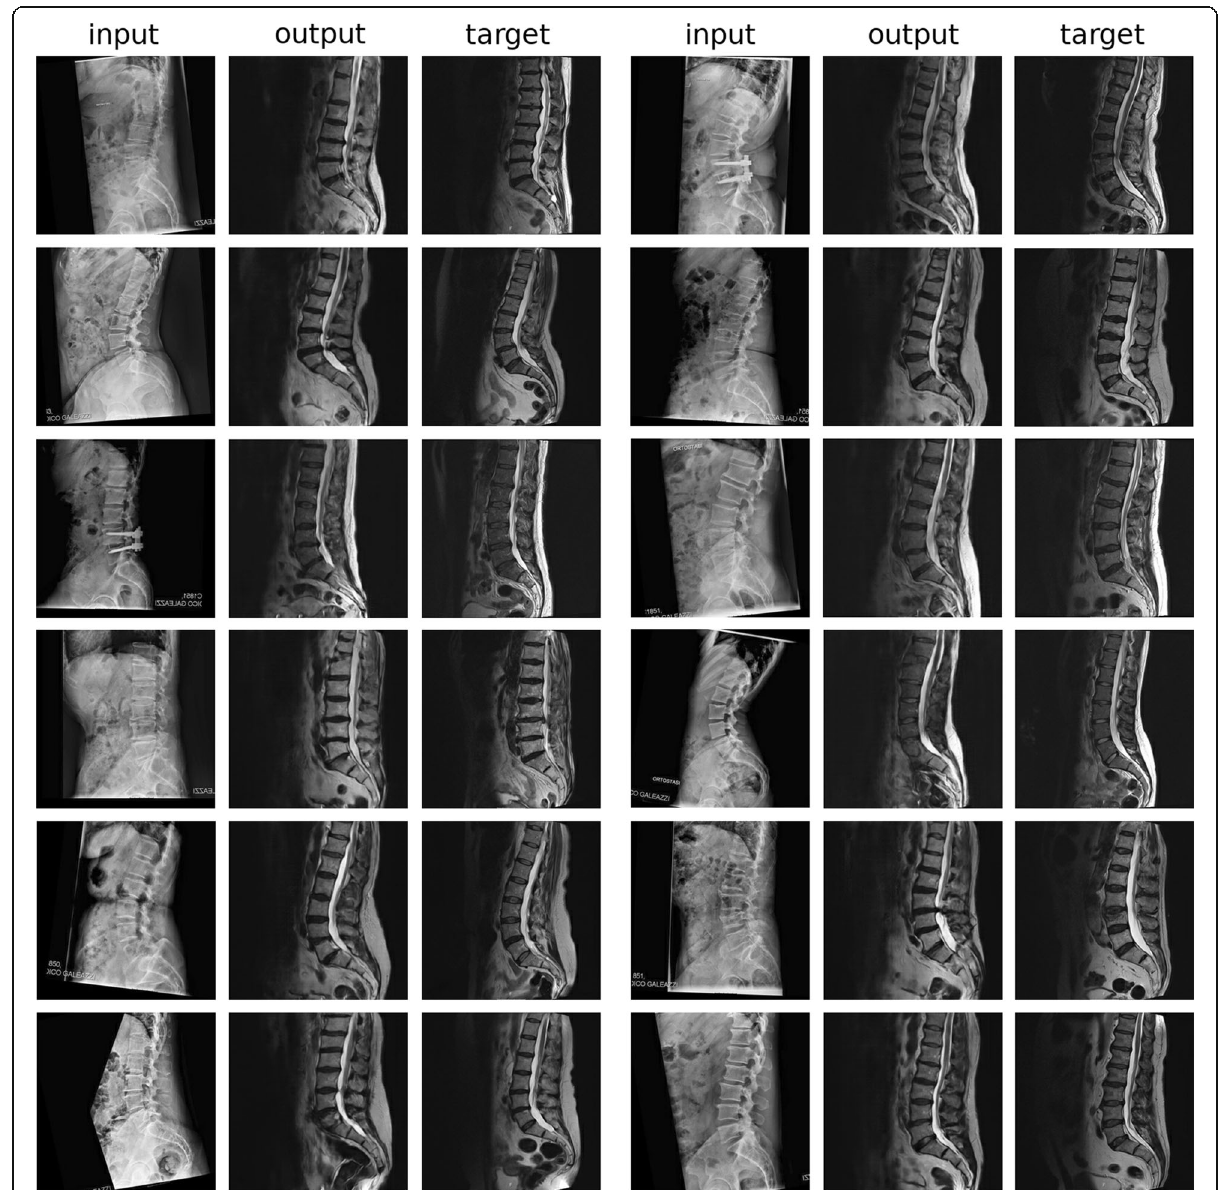
Fig. 6 Representative results (12 patients) of the translation from sagittal x-ray projections to T2W midsagittal MRI scans. input: original x-ray image, registered to match the alignment of the original MRI; output: synthetic T2W midsagittal MRI; target: original T2W midsagittal MRI. A few gross errors in the anatomy can be identified: the L1 in the first and fourth patients on the left ; the sacrum in the first patient on the right ; the thoracolumbar junction in the third patient on the right ; L1 and the sacrum in the fourth patient on the